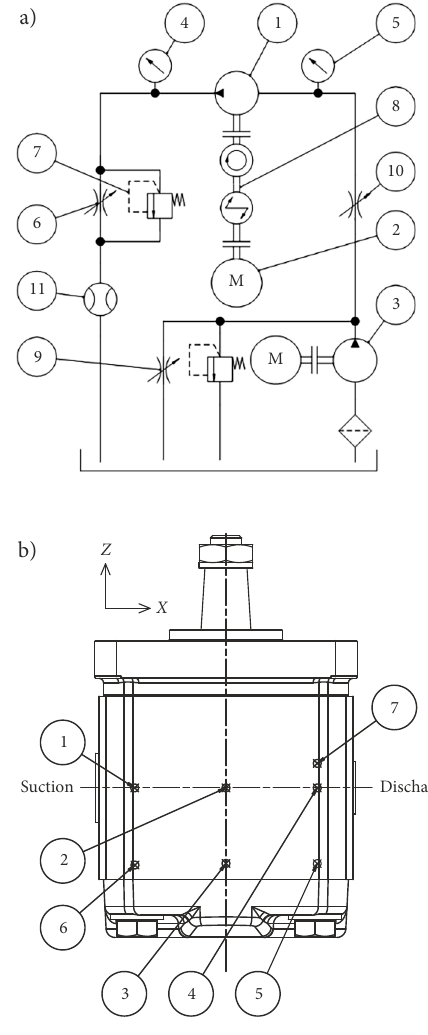
Figure 11. Schematic diagram of a hydraulic system for generating loads on the tested pump (a); locations of the strain gauges on the tested pump